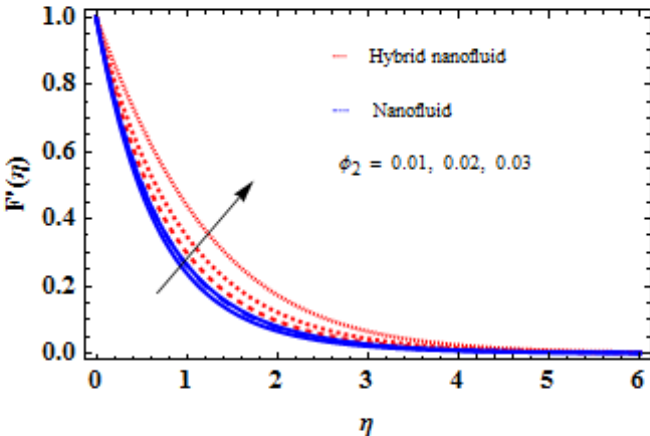
Figure 12. Influence of 𝜙 2 via dust velocity.